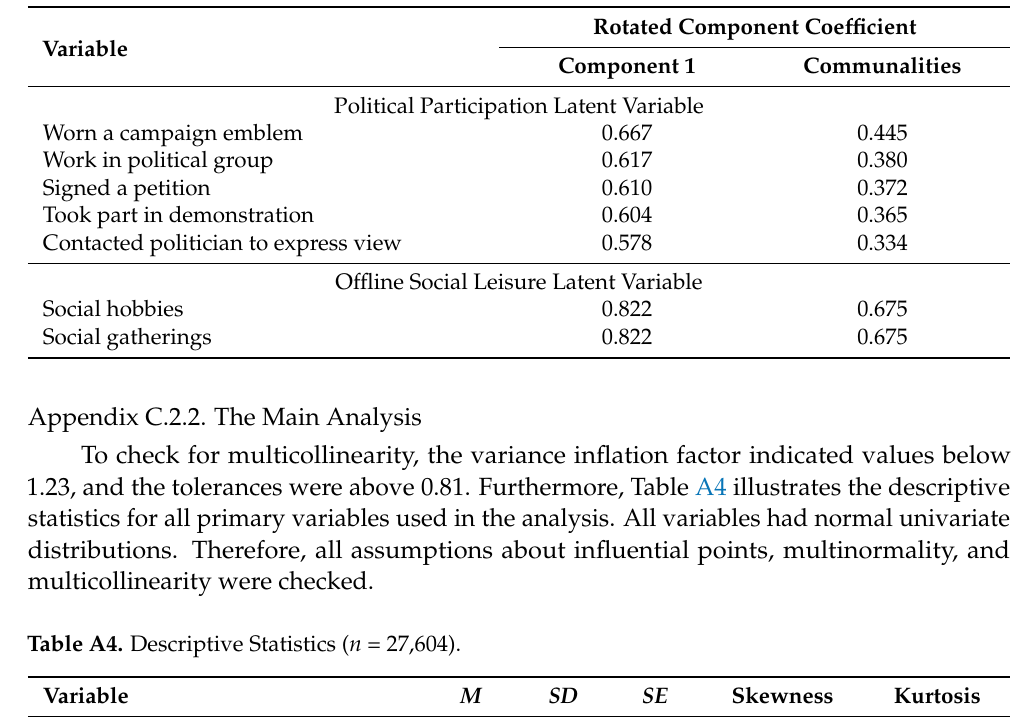
Table A3. Rooted Structure Matrix for PCA with Varimax Rotation of Both Latent Variables.